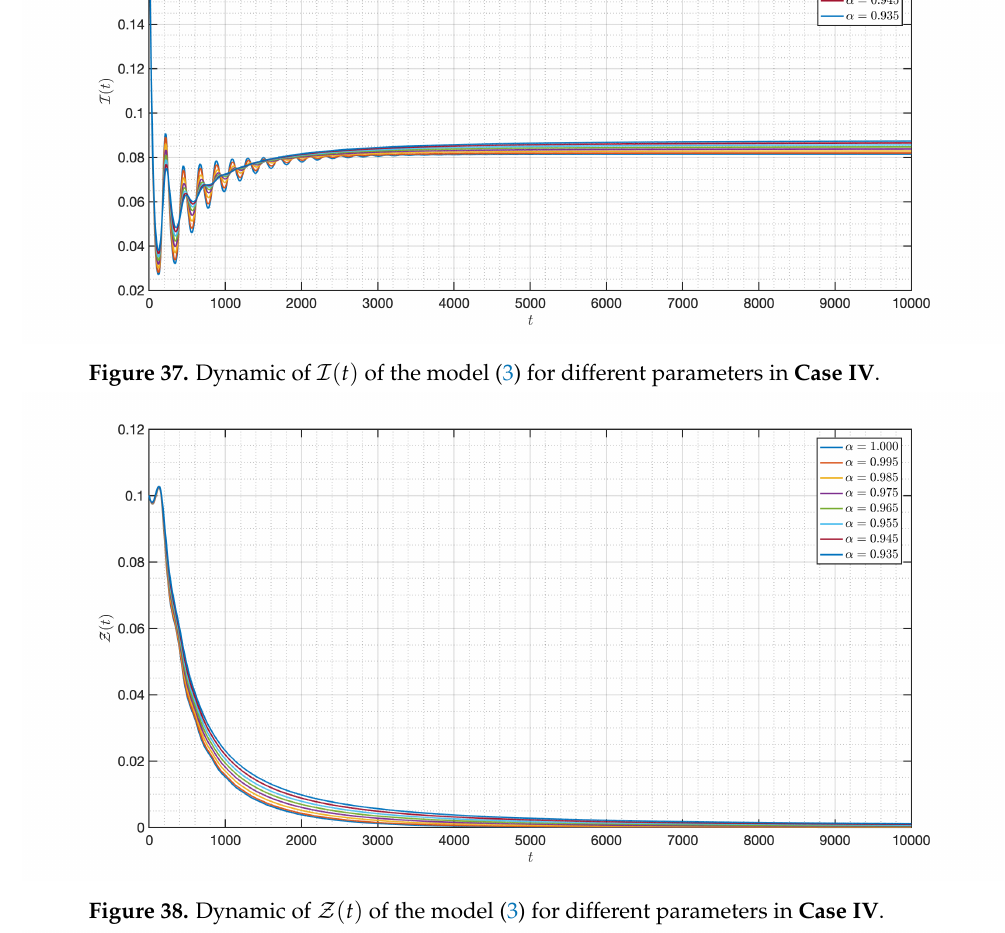
Figure 38. Dynamic of Z ( t ) of the model (3) for different parameters in Case IV .